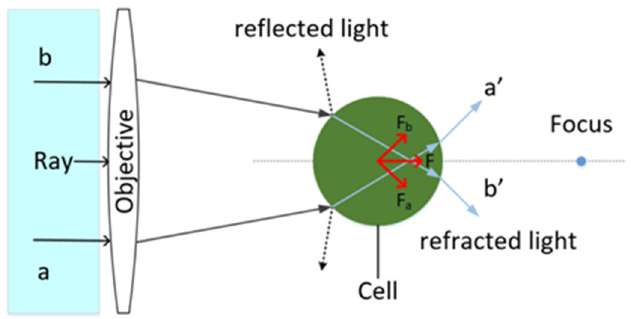
Figure 1. Schematic diagram of optical tweezers capturing